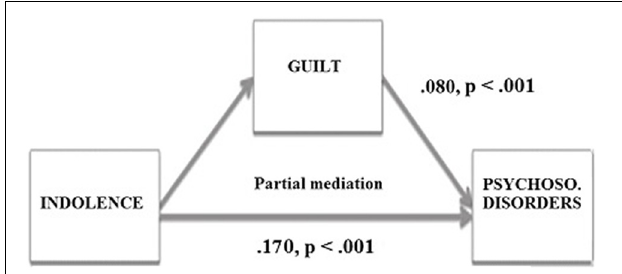
FIGURE 4 | Mediation of the variable Guilt in the relationship between the SQT and Psychosomatic disorders in the Spanish sample.